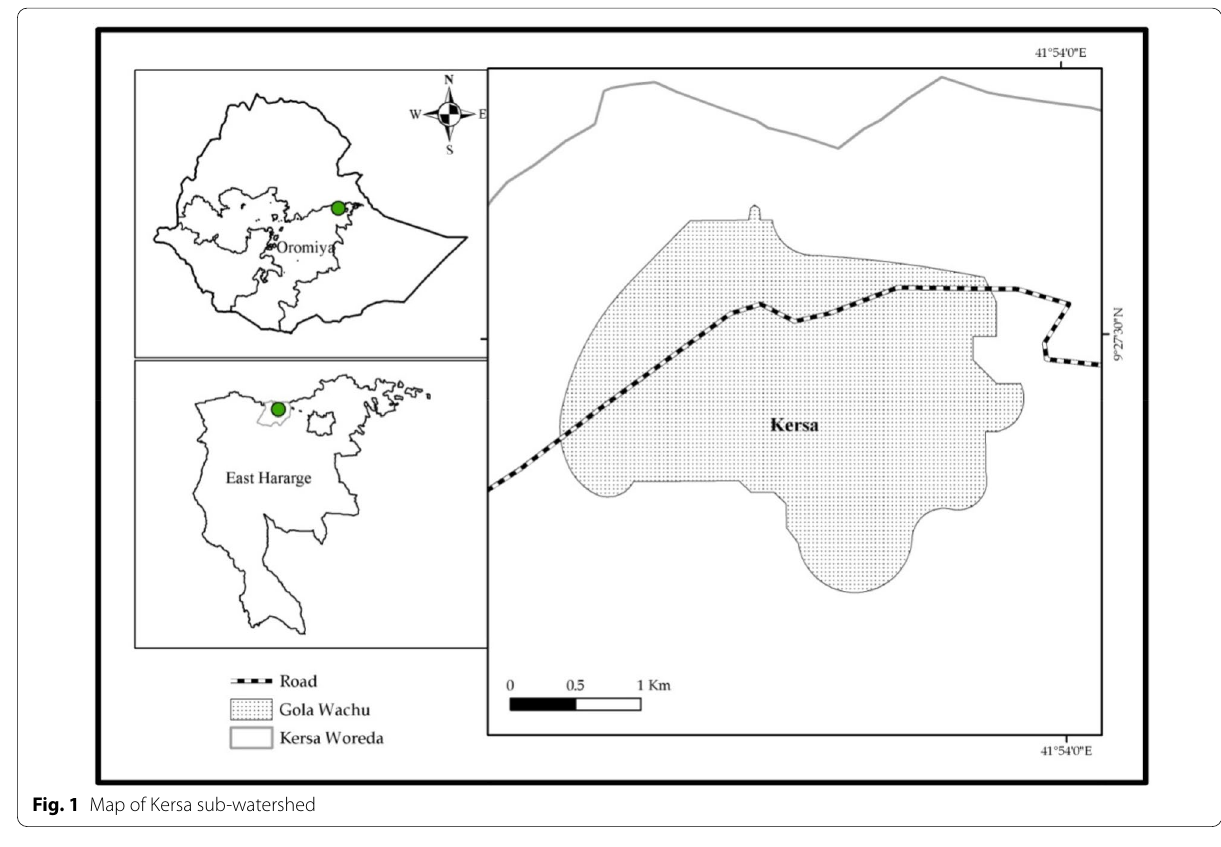
Fig. 1 Map of Kersa sub-watershed